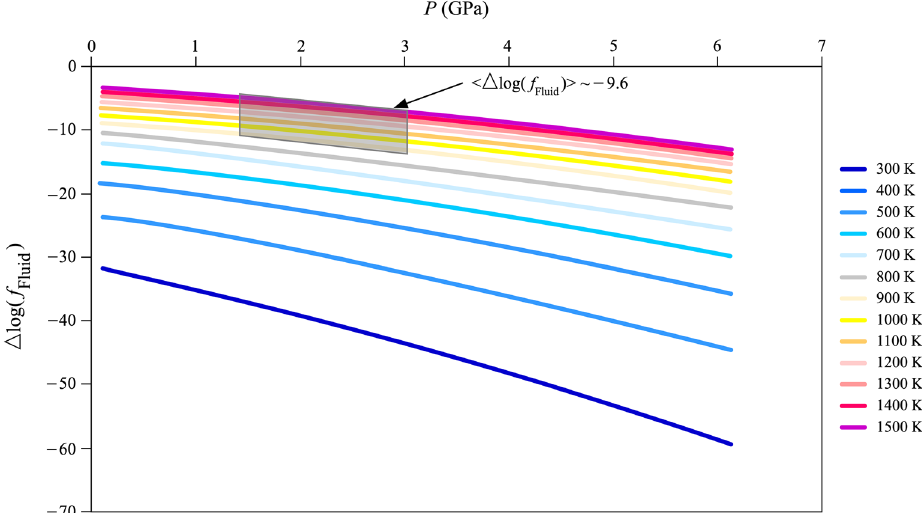
Figure 6. Δ log ( f Fluid ) = log (a Fluid ) = log ( f Fluid )– log ( f Fluid,0 ) of the reaction 2 (K,Na)-phlogopite + forsterite = 7/2 enstatite + spinel + 2 fluid(Na 2 O-K 2 O,H 2 O) along isotherms (300–1500 K) as a function of pressure ( P ). In the P–T range of petrological interest (i.e., 900–1500 K and 1.5–3.0 GPa; grey bar), the mean value of Δ log ( f Fluid ) (< Δ log ( f Fluid ) >) is ~ −9.6. This means that a large amount of energy should be provided to the system to maintain the fluid phase coexisting with phlogopite (and